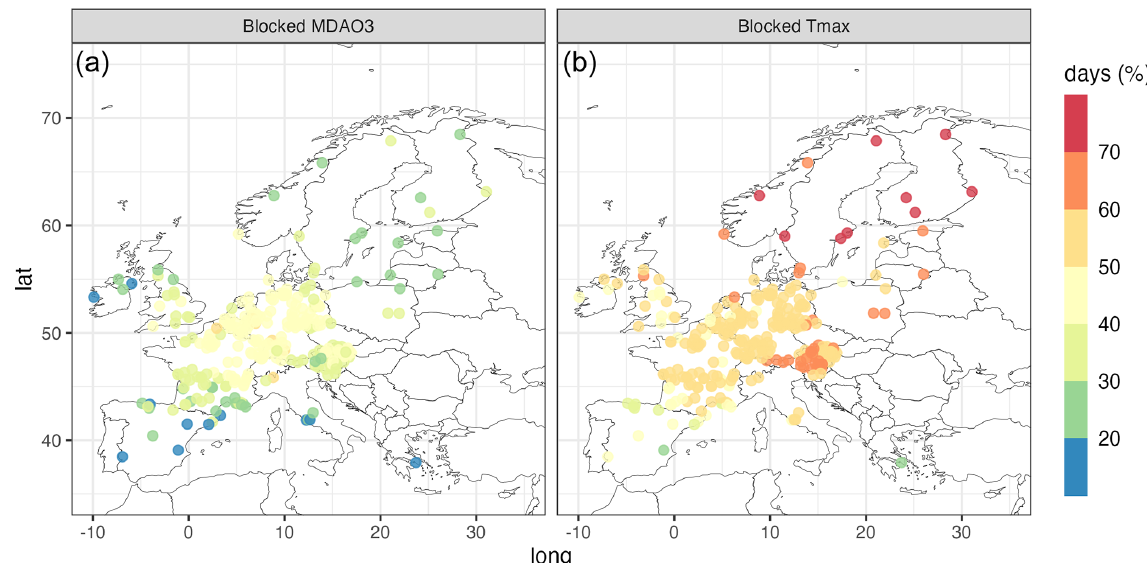
Figure 2. Percentage of days with MDA8O3 (a) and T max (b) exceedances ( > 95th) that are blocked